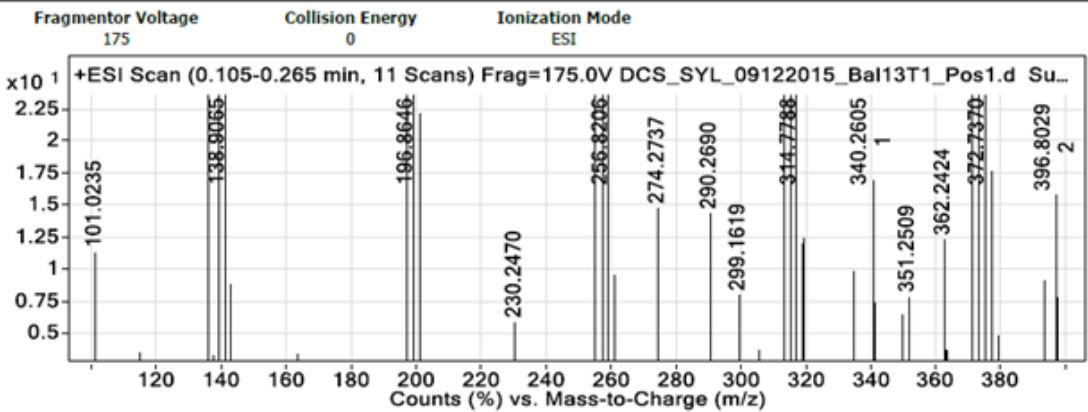
in [HCl] 1.0 M at 2